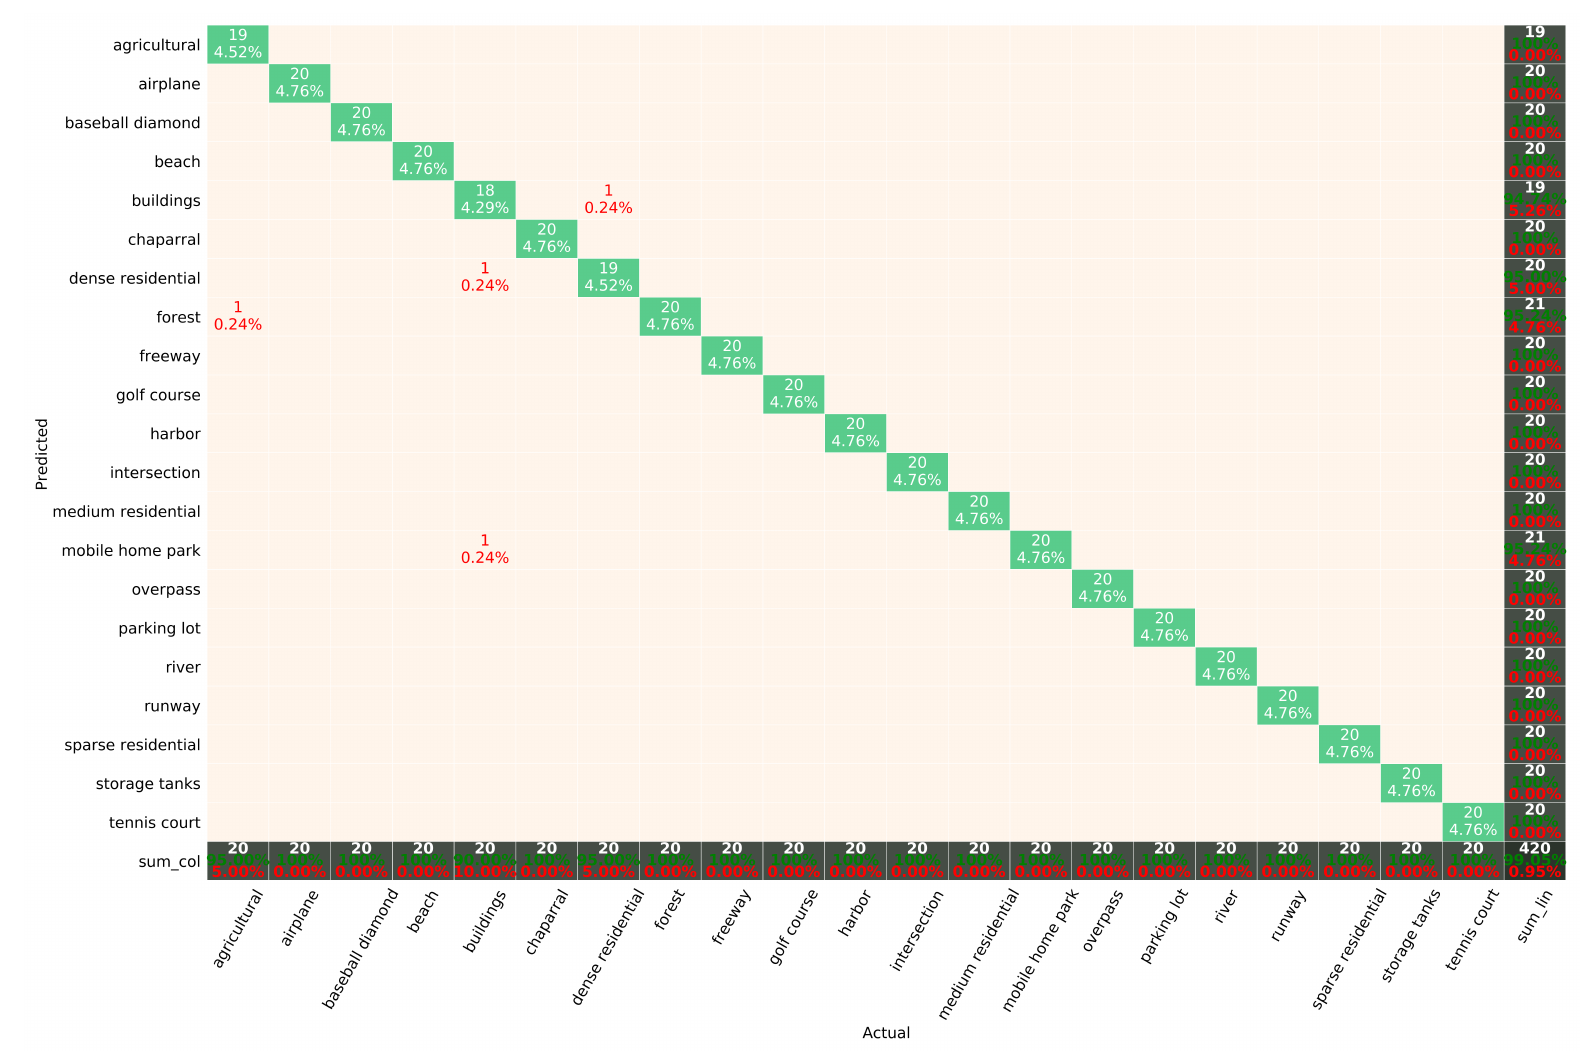
Figure 11. Confusion matrix of RSCNet on UC_MerceLandUse test